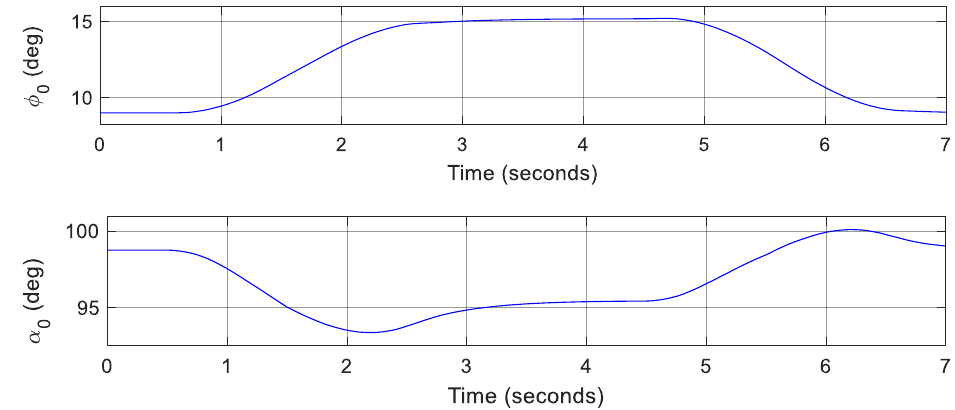
Figure 20. Flight control inputs for transition flight control of linear FWMAV model.